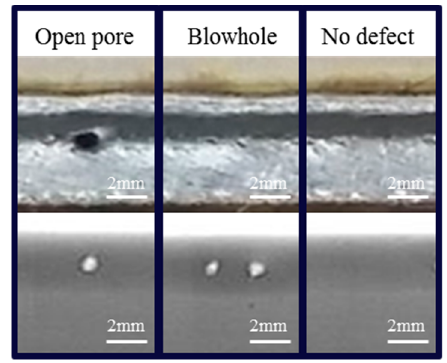
Figure 3. Weld defects by arc welding of galvannealed steel.